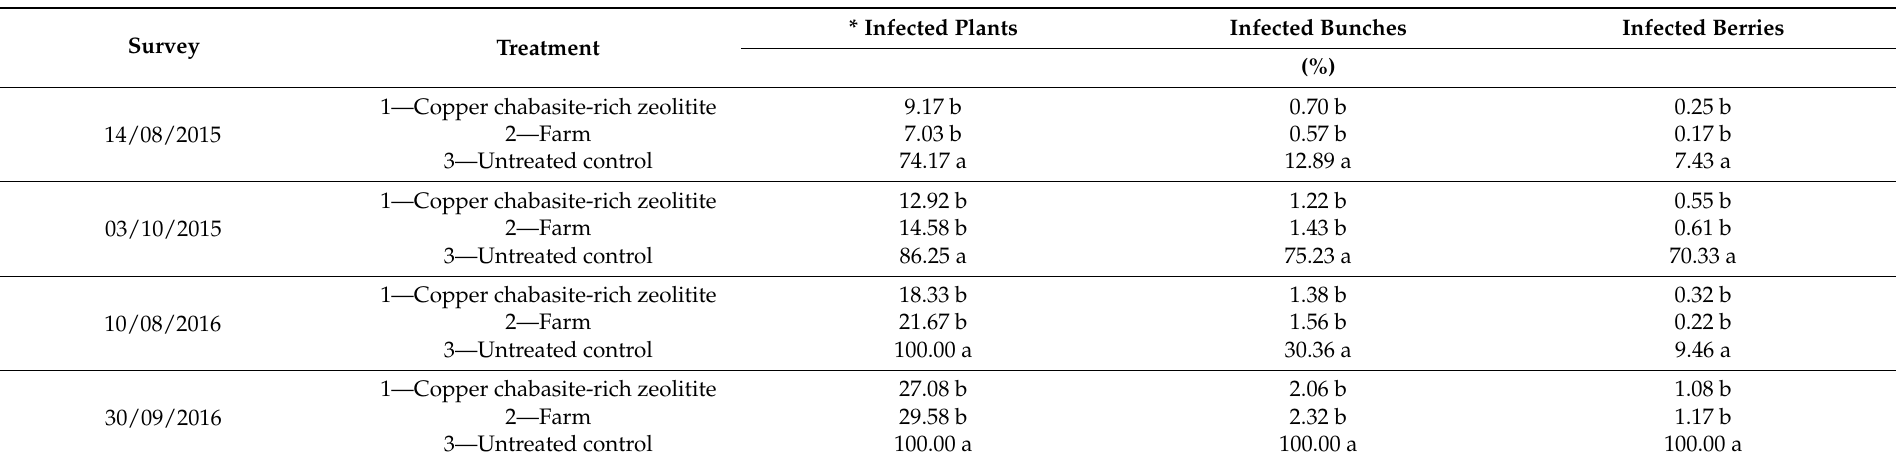
Table 4. Comparison of incidence and severity among control strategies of grapevine downy mildew based on applications of Italian copper chabasite-rich zeolitite or fungicides provided for the farm plan in the Montepulciano cultivar of Ari vineyard: grape surveys.